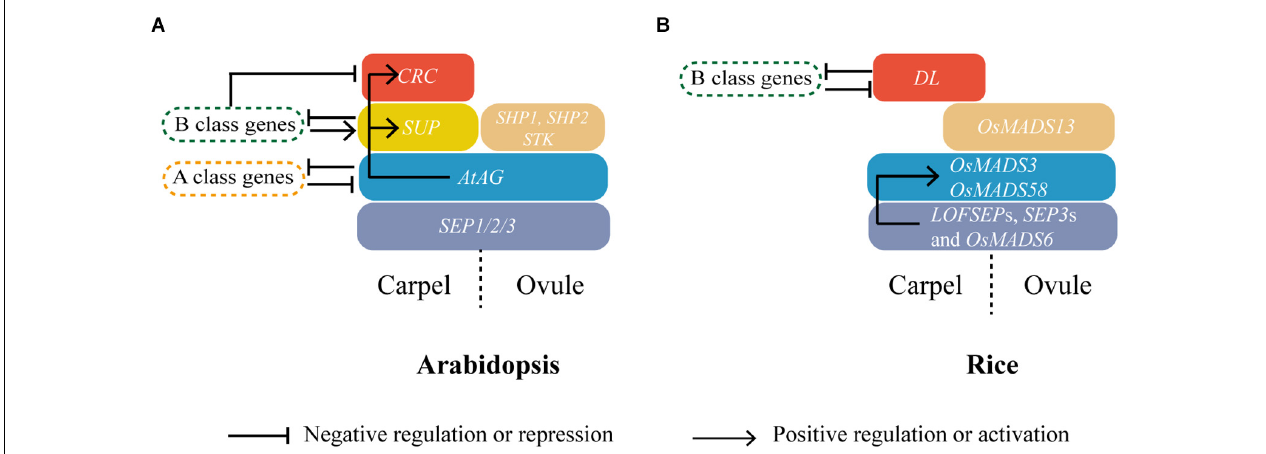
FIGURE 2 | Carpel specification in dicot and monocot model plants Arabidopsis and rice. The expression domains of C-, D-, and E-class genes; SUP ; and CRC , DL in carpel and ovule of Arabidopsis (A) and rice (B) are shown with blue, brown, purple, yellow, and red colors, respectively. Genetic interactions within these carpel identity regulators and other homeotic genes are also indicated. Direct regulations have been shown in Arabidopsis , whereas in rice a direct binding of OsMADS6 has only been shown to the second intron of OsMADS58 (Li et al., 2011a).